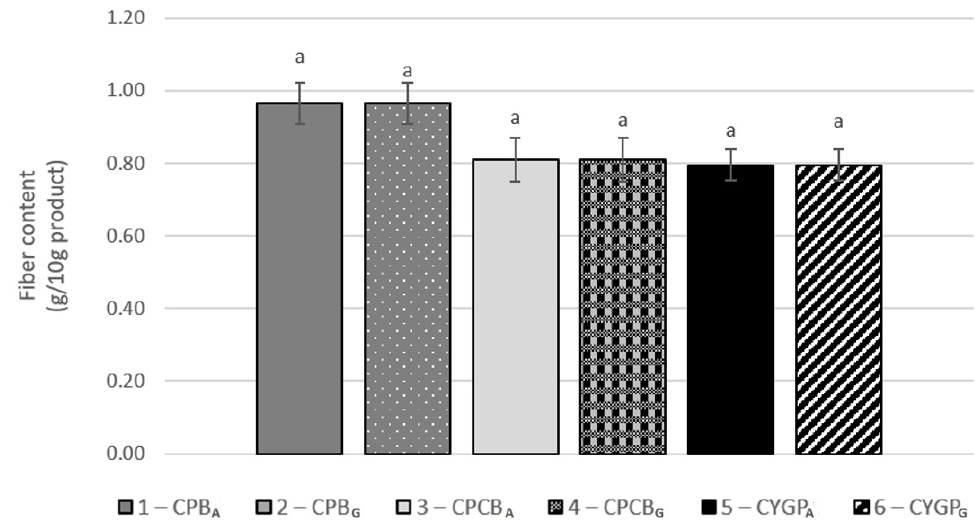
Figure 3. Average content of dietary fibre (pro-health value) in freeze-dried products formed on the basis of vegetables produced with hydrocolloids. The same letters (a) in individual columns indicate the absence of a statistically significant difference between the samples (significance level 0.05). Designations displayed in Table 1. Index (A) next to the formulations symbol—formulations with sodium alginate and calcium lactate, index (G) next to the formulations symbol—formulations with the mixture of locust bean gum and xanthan gum.